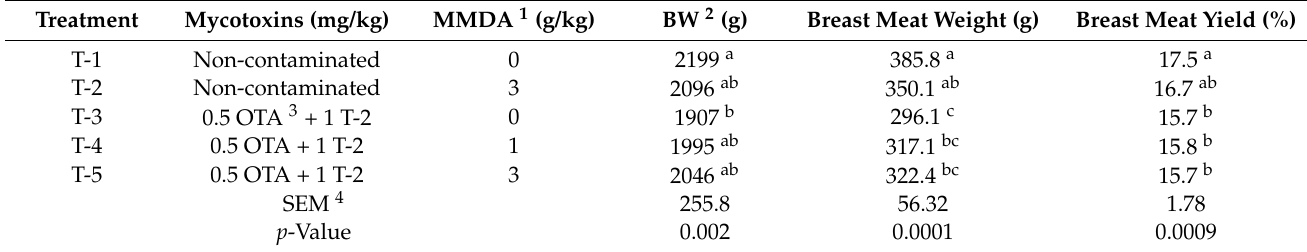
Table 7. The effects of feeding ochratoxin A (OTA) and T-2 mycotoxins, and the addition of a binder mycotoxin product (MMDA) on breast meat yield of broiler